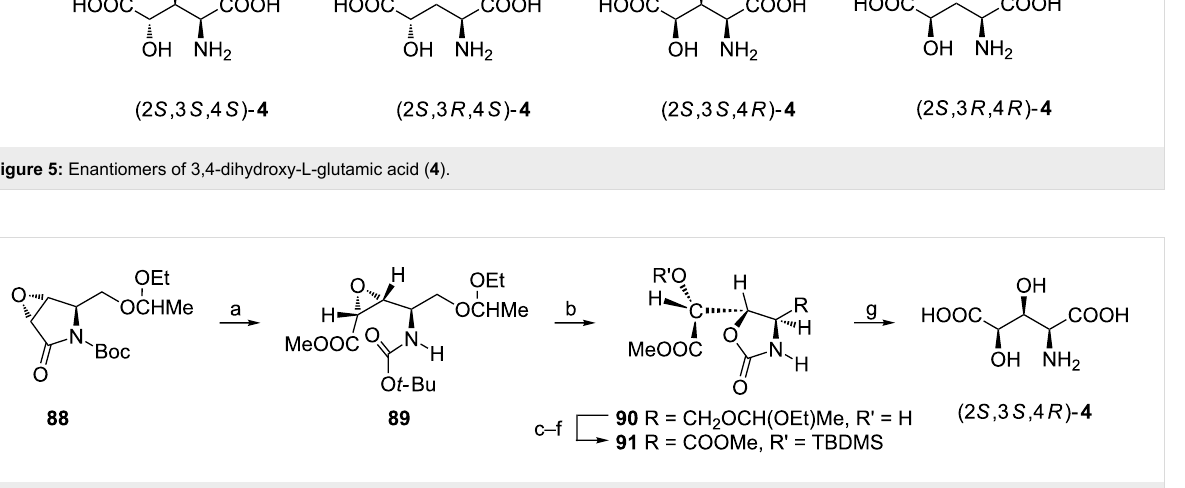
Scheme 23: Synthesis of (2 S ,3 S ,4 R )- 4 from the epoxypyrrolidinone 88 . Reagents and conditions: a) MeOH, THF, KCN (cat.); b) MeOH, SiO 2 ; c) t -BuMe 2 SiCl, imidazole, DMF; d) 0.01 M HCl; e) Jones reagent; f) CH 2 N 2 , ether; g) 6 M HCl,